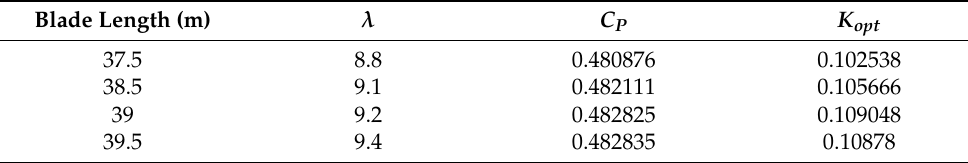
Figure 3. Generator torque-speed curves for wind turbines with different blade lengths. Table 3. Parameters used to track the optimum tip-speed ratio.